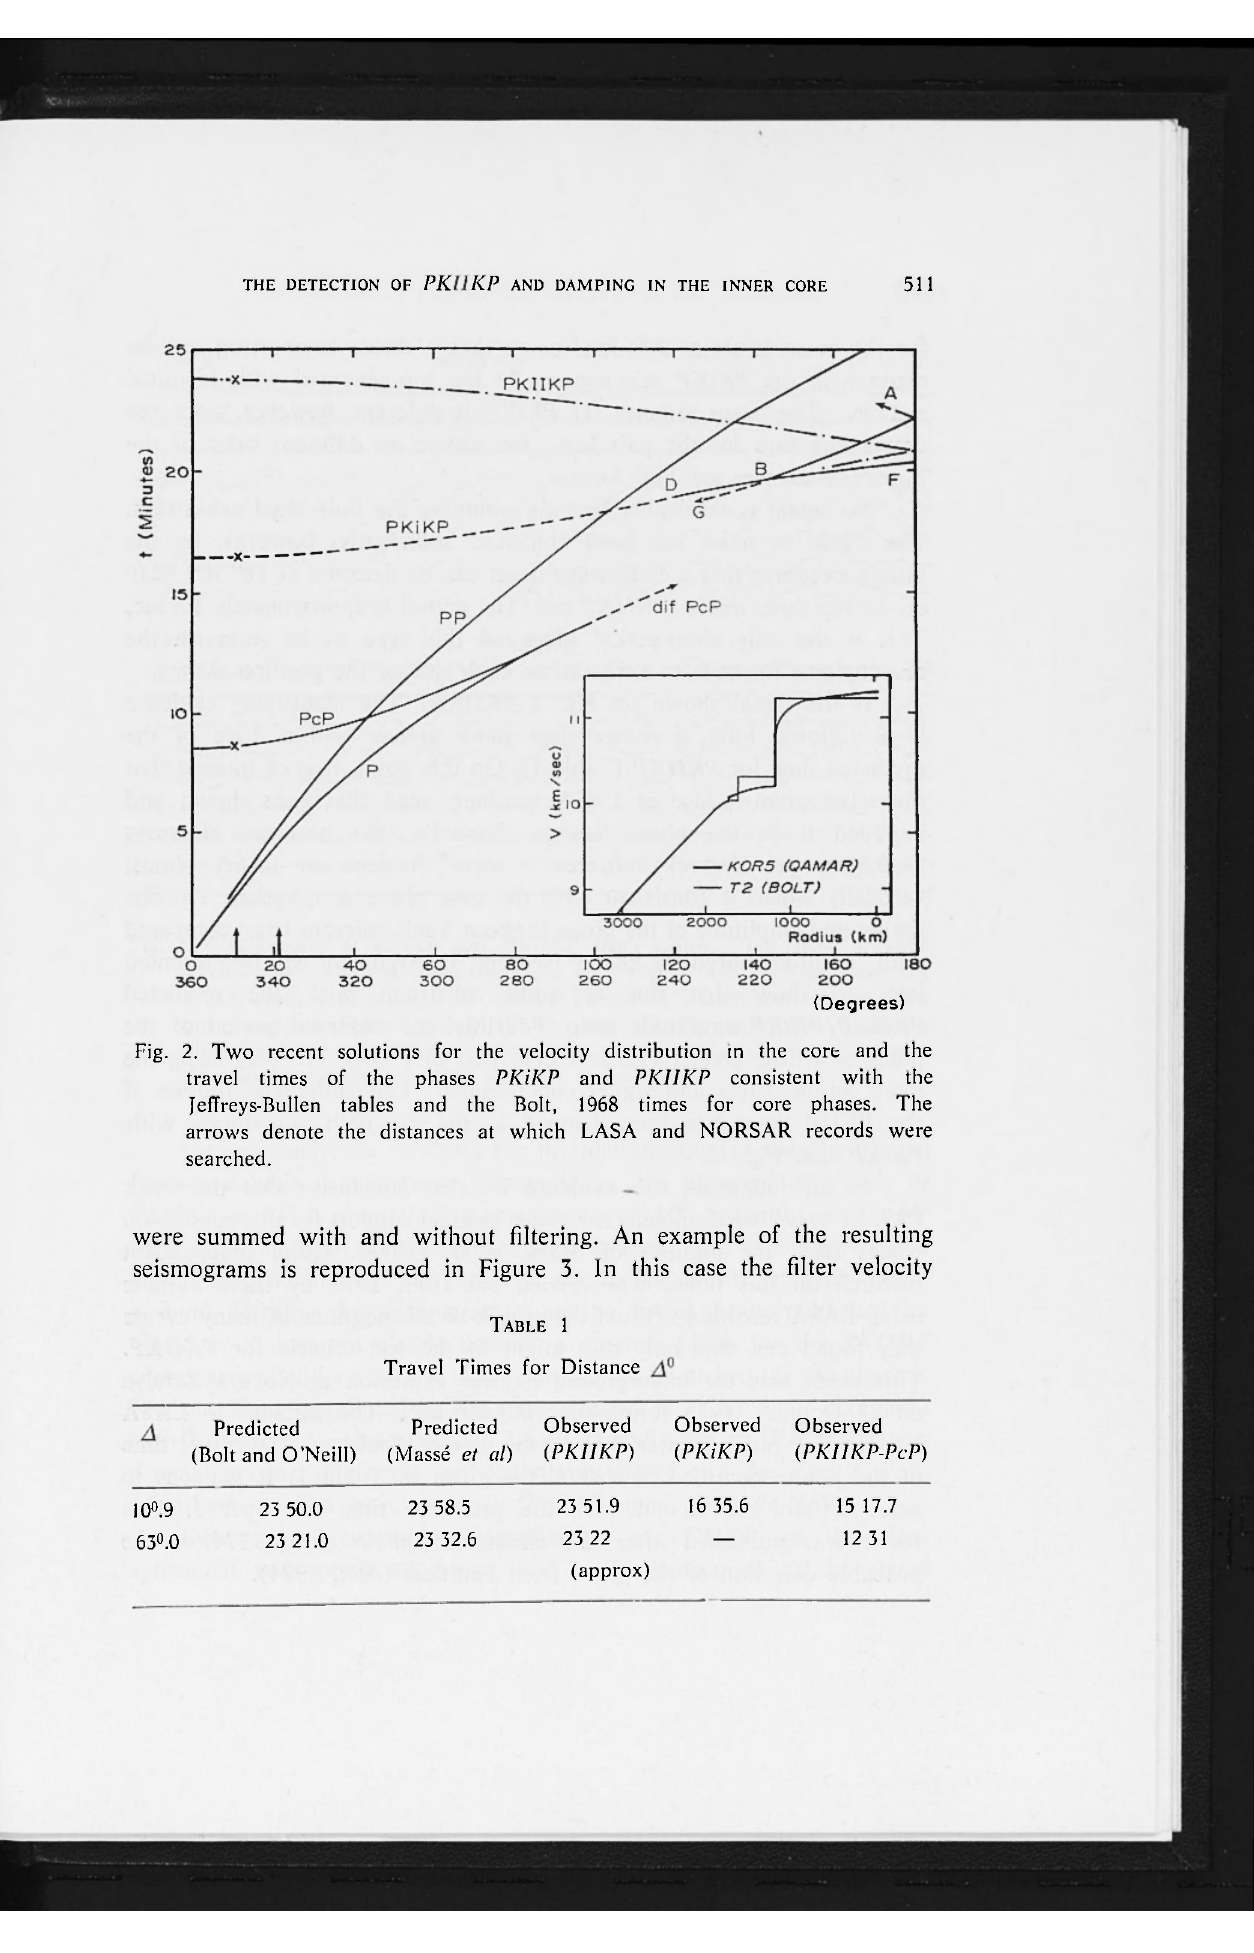
Fig. 2. Two recent solutions for the velocity distribution in the core and the travel times of the phases PKiKP and PKIIKP consistent with the Jeffreys-Bullen tables and the Bolt, 1968 times for core phases. The arrows denote the distances at which LASA and NORSAR records were searched.